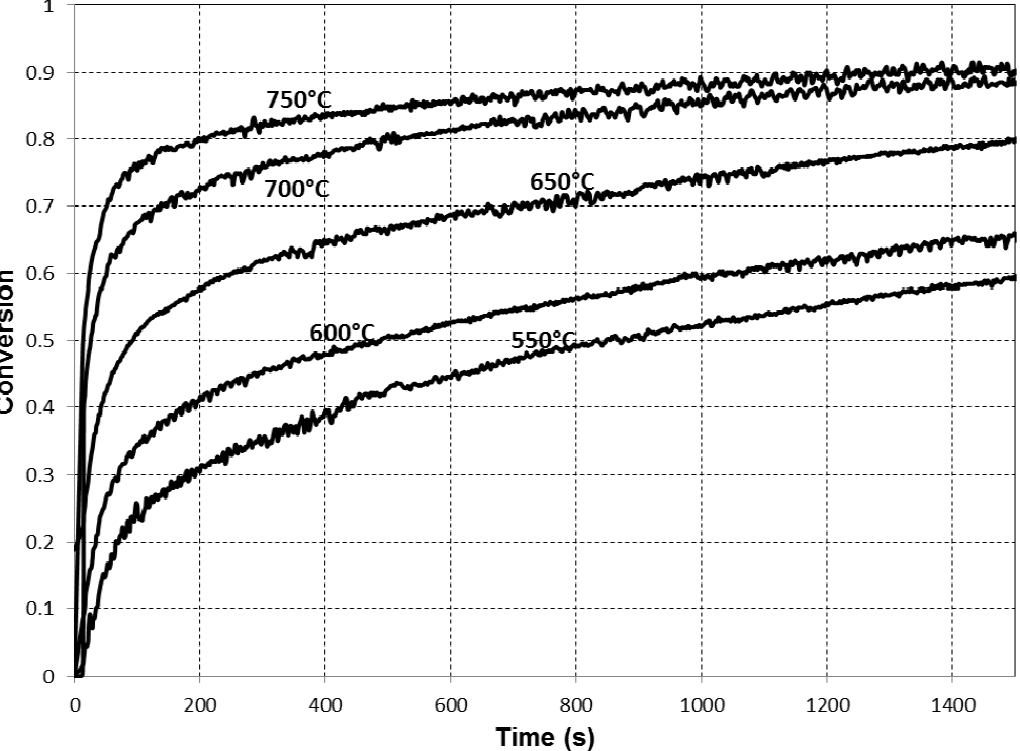
Figure 2. Carbonation behavior of the sample CaAlWM.